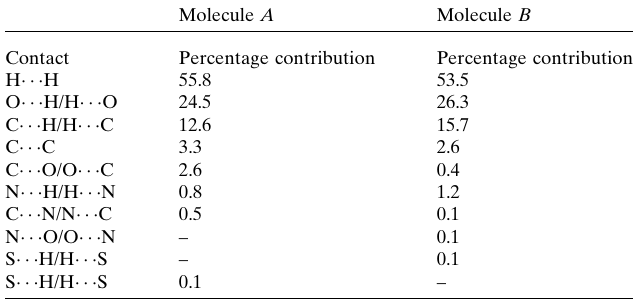
Table 3 Percentage contributions of interatomic contacts to the Hirshfeld surfaces for molecules A and B of the title compound 3